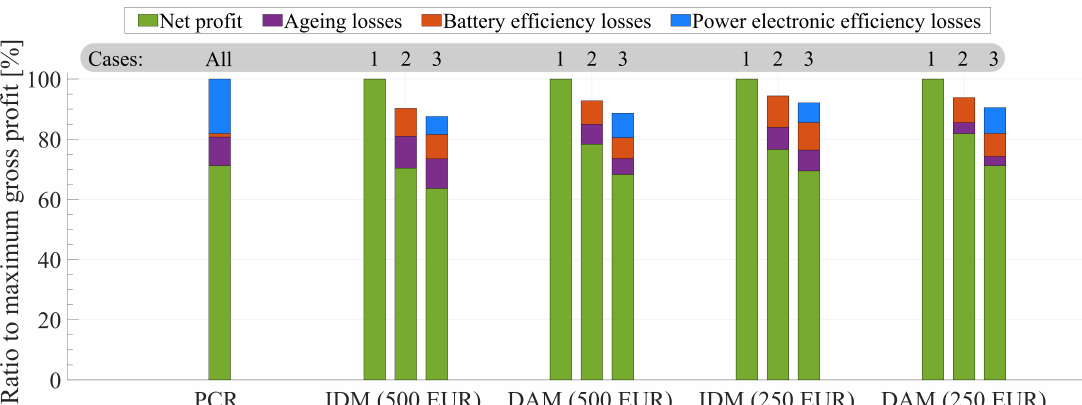
Figure 7. Comparison of revenue and losses resulting from battery ageing, as well as dissipation losses, for the storage